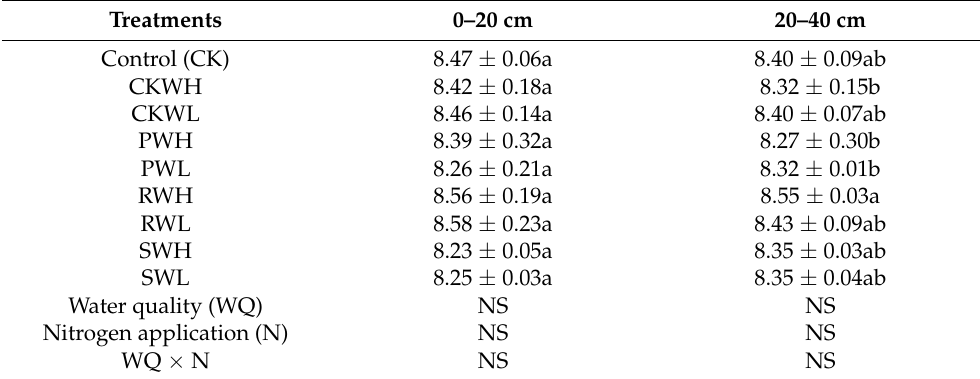
Table 3. Changes in soil pH under different irrigation